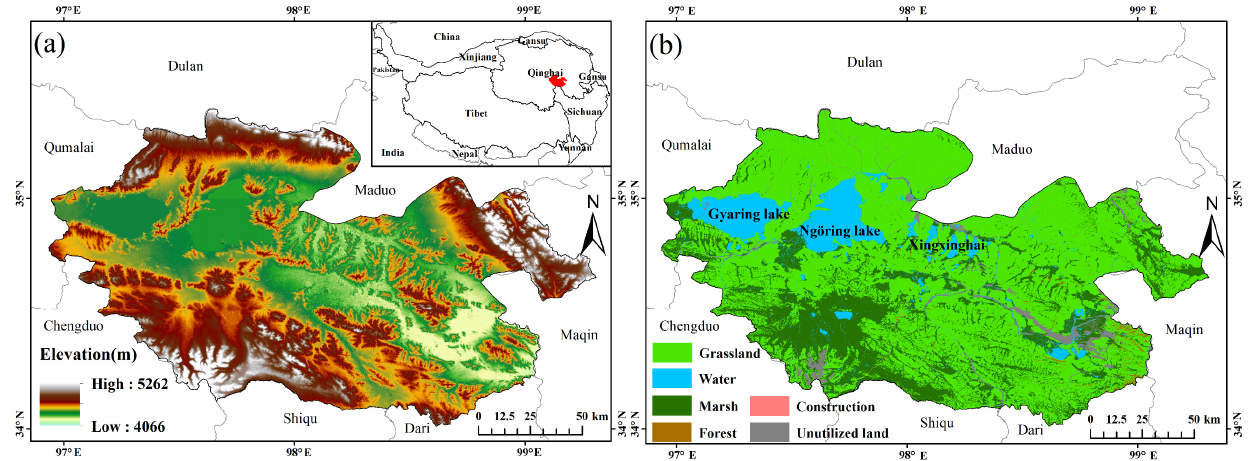
Figure 1. Study area: ( a ) geographical location and altitude above sea level; ( b ) classification of the third national land survey.